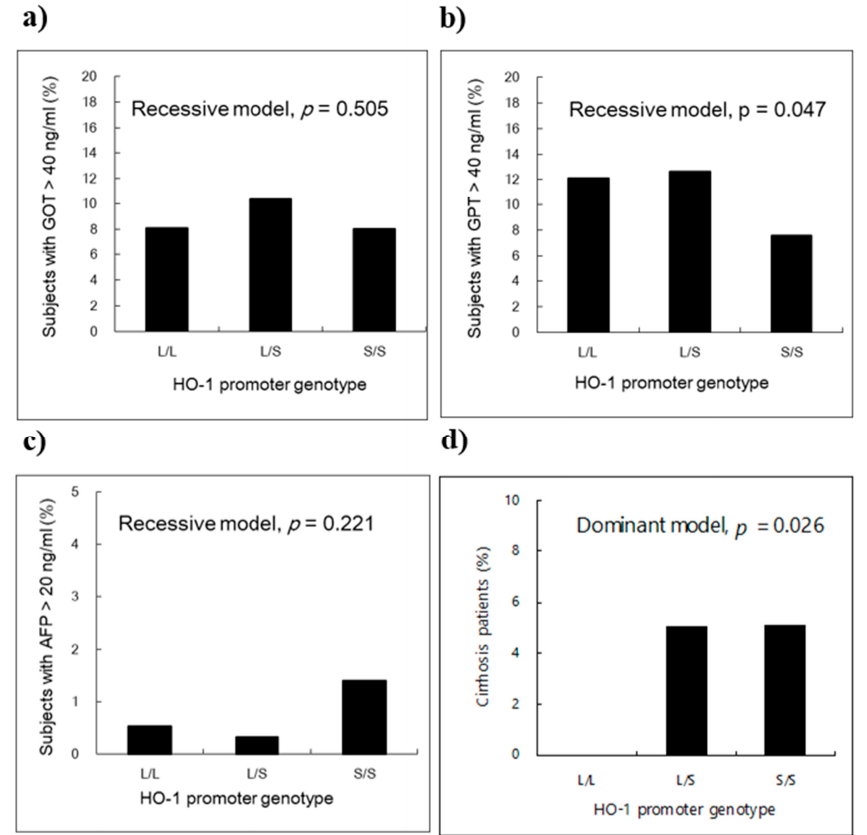
Figure 1. Percentage of study subjects with liver-related injury markers and liver cirrhosis history by the HO-1 promoter genotype. ( a ) Abnormal GOT (>40 U/I in serum). ( b ) Abnormal GPT (>40 U/I in serum). ( c ) Abnormal AFP (>20ng/mL in serum). ( d ) Liver cirrhosis history. p -values were derived from χ 2 test based on a dominant or recessive genetic model, where appropriate. The